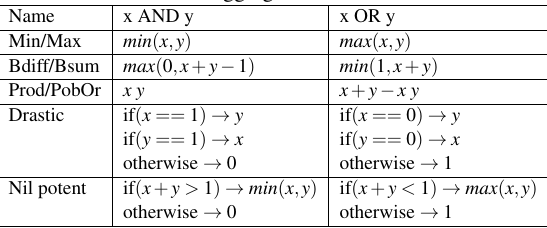
Table 2. Aggregation methods.